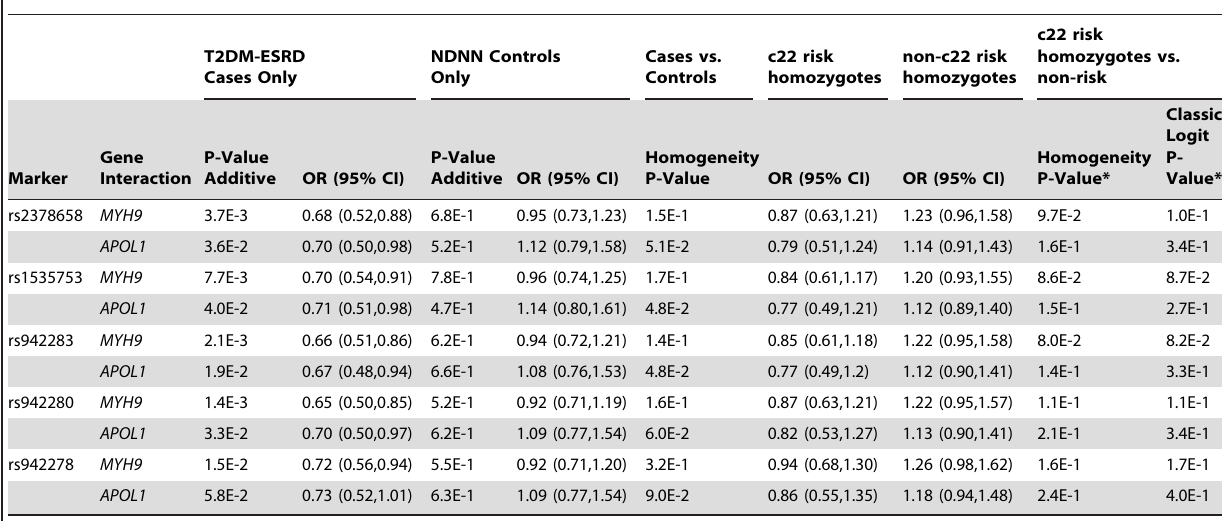
Table 3. Replication sample chromosome 22- FRMD3 interaction analysis.